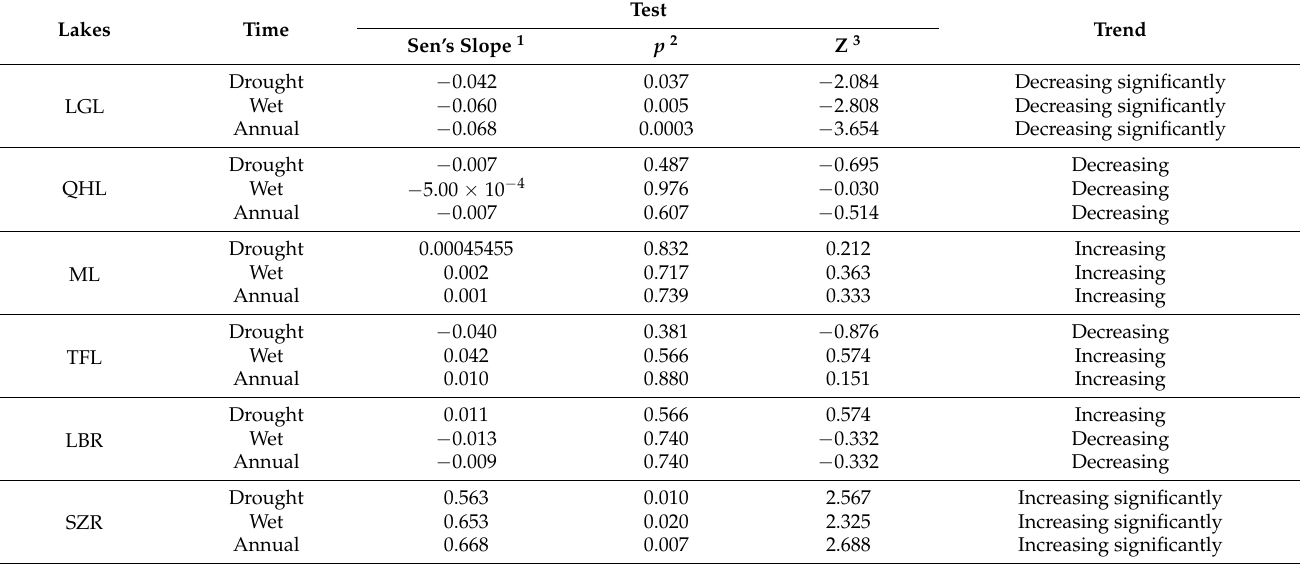
Table 5. Mann-Kendall trend test for water area of typical lakes in Sichuan